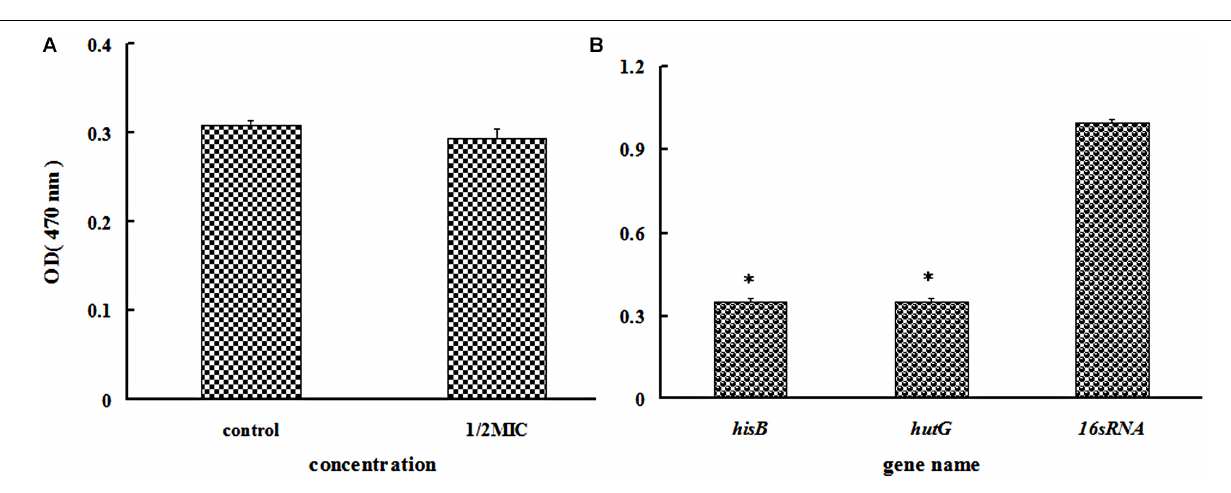
Figure 5 | (A) Determination of the histidine content of Staphylococcus xylosus 700404 untreated or treated with azithromycin (1/2-MIC). (B) Effect of azithromycin (1/2-MIC) on the mRNA expression of hisB and hutG genes in Staphylococcus xylosus 700404. The expression was normalized to that of 16S rRNA. Controls refer to the absence of cefquinome. ∗ P < 0.05 indicated significant difference, compared to the control bacteria. Data are expressed as the mean +